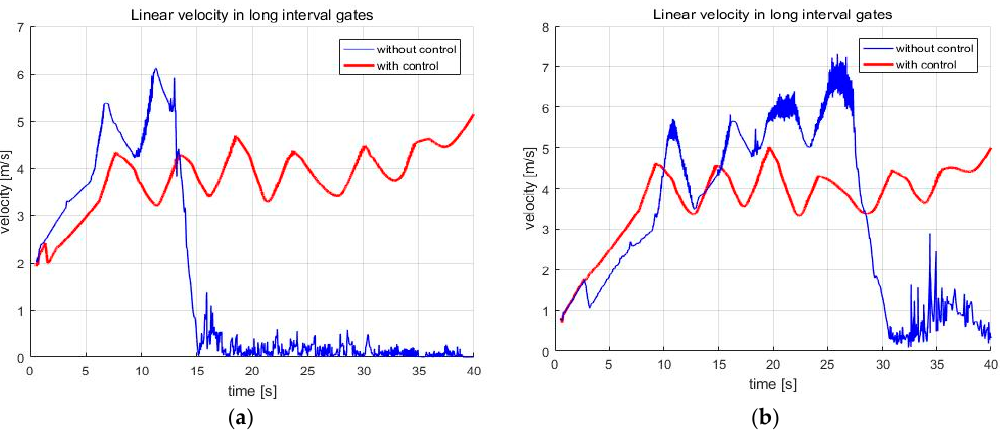
◦ ; ( b ) µ slope = 0.12, α = 10